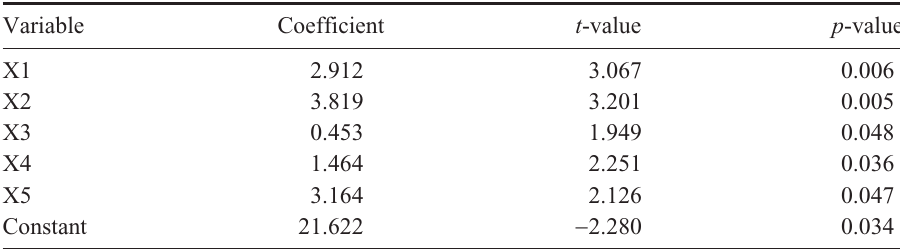
Table 3. Regression model